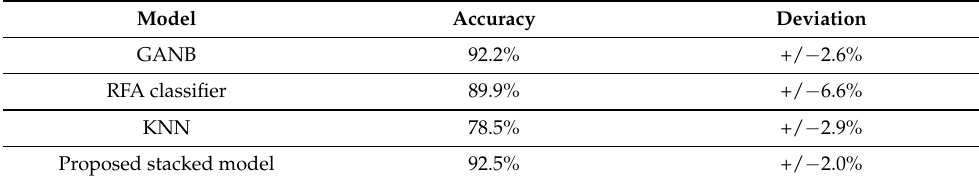
Table 4. Accuracies of various ML models.